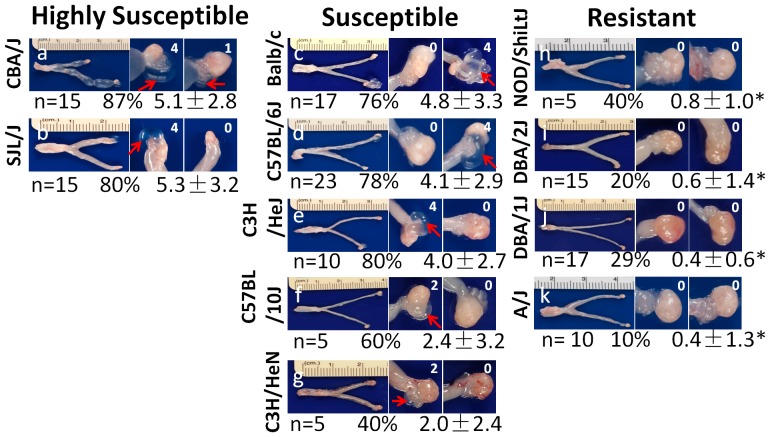
Hydrosalpinx development in 11 strains of mice following lower genital tract infection with C. muridarum.Eleven different strains of female mice as indicated on the left of each representative image (with n = 5 to 23 mice in each strain as marked below each image) were intravaginally infected with C. muridarum. Sixty to 80 days after infection, all mice were sacrificed for observing hydrosalpinx. A representative image from each strain of mice is presented with the whole genital tract in the left and the magnified oviduct/ovary portion in the right. The number of mice with positive hydrosalpinx (as marked with red arrows in the magnified oviduct/ovary images) were counted and recorded as % of hydrosalpinx-positive mice. Furthermore, the severity of each hydrosalpinx was scored based on the criteria described in the Materials and Methods and marked with numbers in white in the corresponding images. The hydrosalpinx severity scores were compared between different strains of mice using Wilcoxon Rank Sum while the hydrosalpinx incidences were compared using Fisher's Exact. Note that the hydrosalpinx scores of NOD/ShiLtJ (panel h), DBA/1J (i), DBA/2J (j) and A/J (k) mice were <1 and significantly lower than those from other strains of mice (as noted with stars, p<0.05). These four strains were designated “resistant” to hydrosalpinx induction (right column) while the CBA/J (a) and SJL/J (b) mice with the highest rates and the most severe hydrosalpinx was designated “highly susceptible” (left column). The remaining strains all developed significant hydrosalpinx, thus were designated as “susceptible” (c–g in the central column).